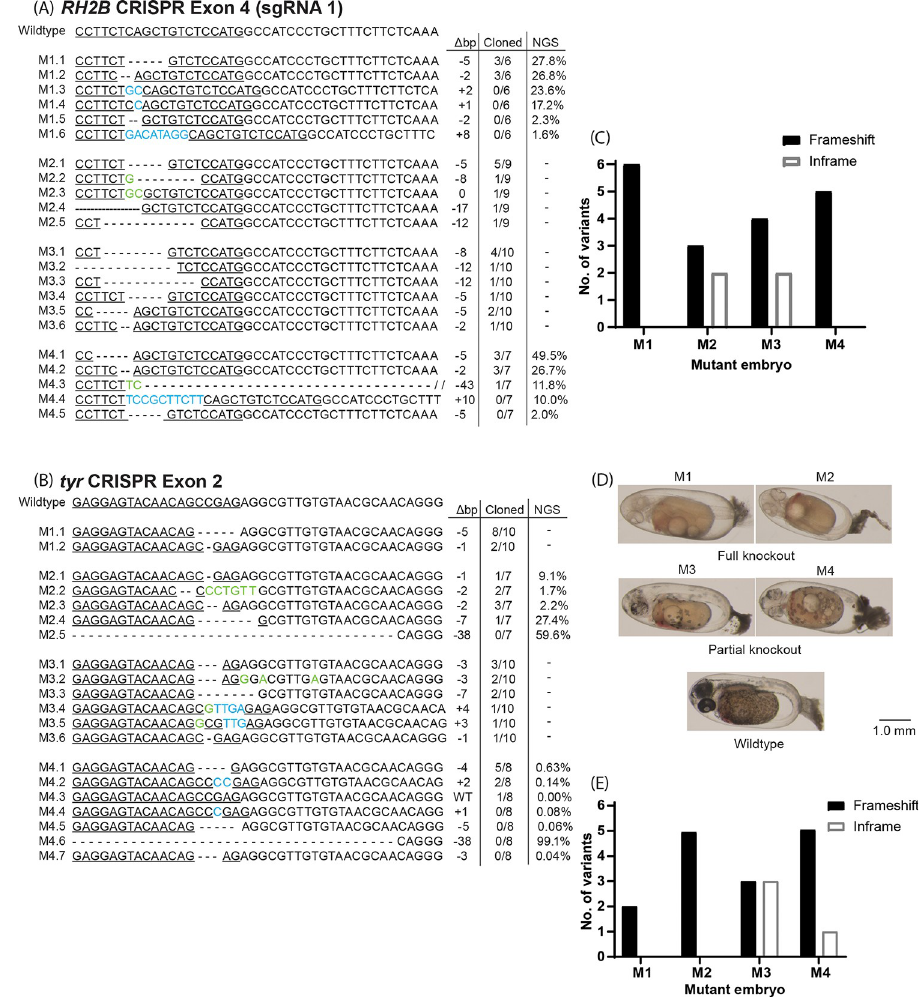
Fig 3. Genotype analysis of RH2B mutant Amphiprion ocellaris embryos. Subcloned sequences and next generation shotgun amplicon sequences (NGS) belonging to A . ocellaris embryos (clutch 3, sgRNA RH2B 1; clutch 12, sgRNA tyr 1) with mutations at targeted sequences (underlined) located on (A) Exon 4 of the RH2B opsin gene, and (B) Exon 2 of the tyr gene. Wildtype (WT) sequences are included for reference. Mutations included deletions (dashes), substitutions (green), and insertions (blue). Sequence labels on the left-side indicate mutant embryo and allele no., while numbers on the right-side indicate the base pair change ( Δ bp), proportion of each allele out of the total number of cloned sequences for each embryo, or the percentage (%) of reads out of total reads for NGS. (C) Number of frameshift and in-frame mutations per RH2B mutant embryo. (D) Micrographs of tyr mutant A . ocellaris embryos exhibiting full knockout ( tyr -M1 and -M2) and partial knockout ( tyr -M3 and -M4) phenotypes, and a wildtype embryo for comparison. (E) Number of frameshift and in-frame mutations per tyr mutant embryo.